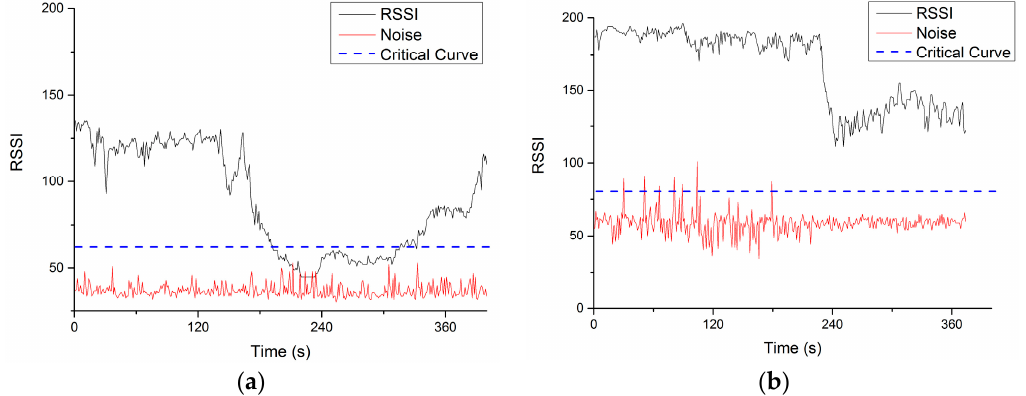
Figure 20. RSSI, noise, and critical curve of both ( a ) UAV “Son” and ( b ) UAV “Mom”.